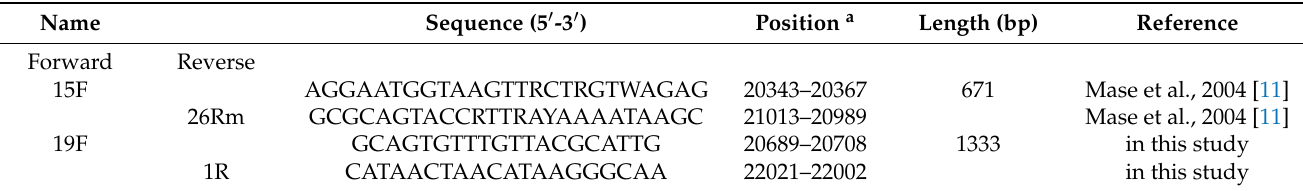
Table 2. List of RT-PCR